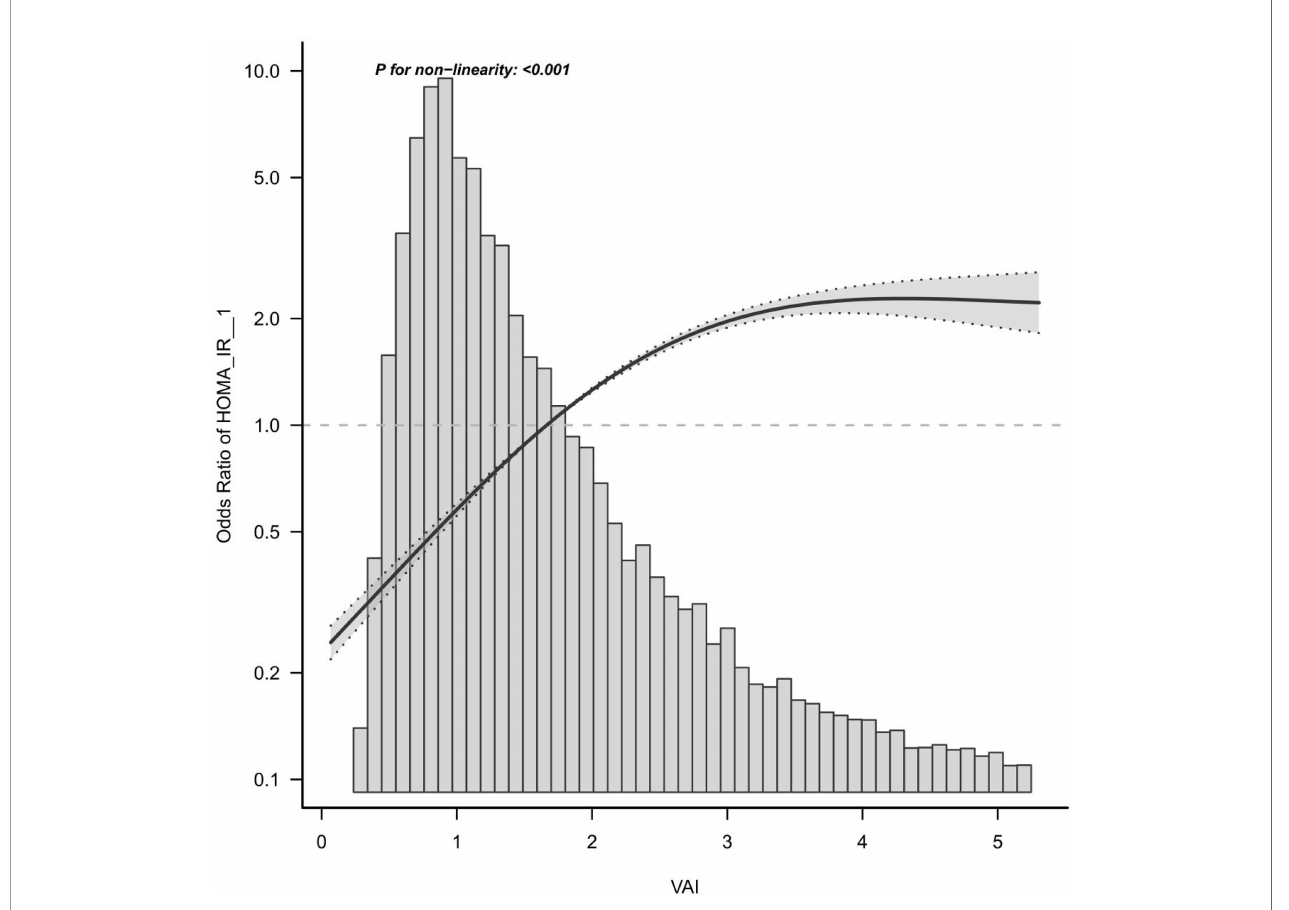
FIGURE 2 | Curve fi tting analysis of VIA and